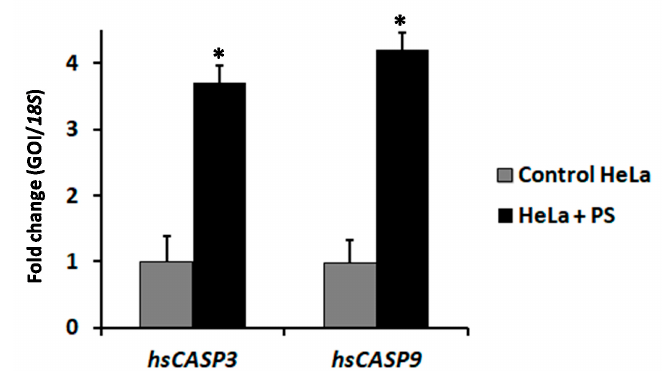
Figure 5. RT-qPCR analysis of apoptosis-related genes in HeLa cells. HeLa cells were treated for 24 h with 12.5 µg/mL of solubilized and activated PS proteins from Bt5. Expression profile was comparable with that obtained with Bt7. Relative expression was determined with the 2 −ΔΔ Ct method using the PCR efficiencies determined with the standard curve included in each run. Each data point represents the results obtained from three independent batches of cDNA made. Expression of target genes (Gene of interest (GOI), hsCASP3 and hsCASP9 ) was normalized to that of the housekeeping gene 18S, represented as mean ± SD, and is expressed as fold-change. (*) indicates significantly different mean values at P < 0.05 using a paired Student’s t -test.